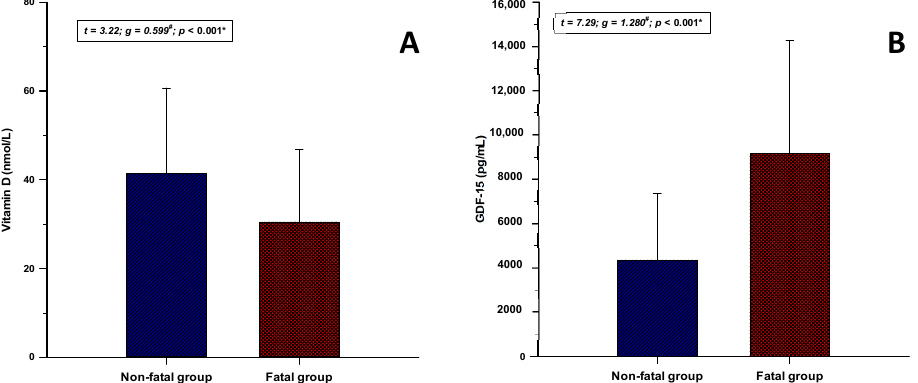
Figure 2. Comparison of the ( A ) vitamin D and ( B ) GDF-15 levels between the fatal ( n = 47) and the non-fatal group ( n = 105). Data are presented as mean ± standard deviation. Abbreviations: GDF-15—growth differentiation factor-15. * Student’s t -test. # Hedges’ g. There was a significant positive correlation between serum catestatin levels and vit- amin D levels (r = 0.338; p < 0.001) and significant negative correlation between serum catestatin levels and GDF-15 levels (r = − 0.345; p < 0.001) (Figure 3). Moreover, catestatin had a significant positive correlation with systolic BP (r = 0.170; p = 0.036) and diastolic BP (r = 0.201; p = 0.013) (Table 3). Figure 3. Catestatin correlation with ( A ) vitamin D and ( B ) GDF-15 in the whole study sample ( n = 152). * Pearson’s correlation coefficient.